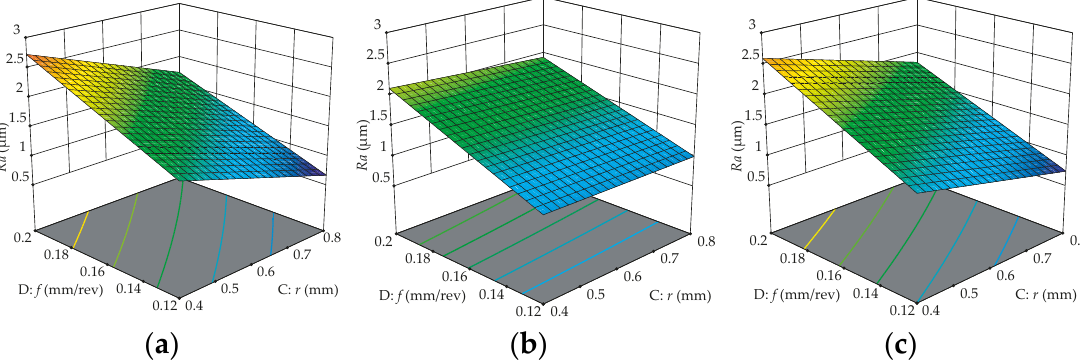
Figure 10. Predicted effect of feed rate and nose radius on Ra surface roughness for cutting tools: ( a )